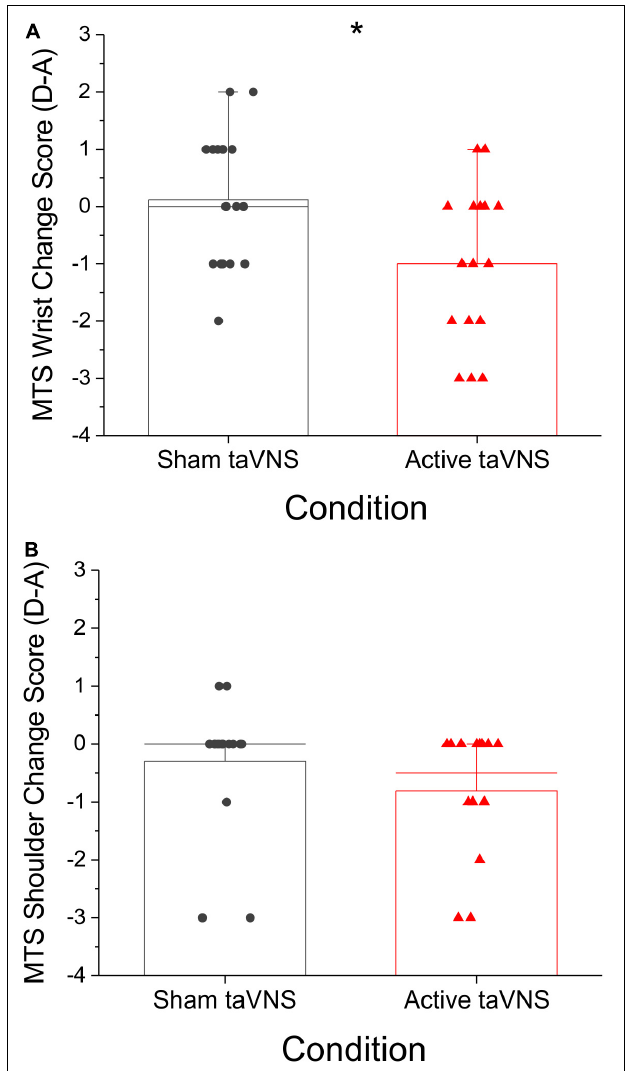
FIGURE 3 | taVNS delivered during robotic therapy extension movements significantly reduced spasticity for the active taVNS group ( N = 16) compared to sham ( N = 17) at discharge (mean raw change score ± SEM), but not follow-up (data not shown). Lower (more negative) scores indicate a greater reduction in spasticity. (A) MTS Wrist/Hand change score at discharge was significantly reduced for the active group ( *P < 0.05, Mann-Whitney U -test, U = 77.0; sham = + 0.17 ± 0.26, active = –0.79 ± 0.31). (B) MTS shoulder change score at discharge approached a significant difference for the active taVNS group ( P = 0.051, U = 88.50, Mann-Whitney U -test, sham = –0.25 ± 0.24, active = –0.72 ± 0.25).